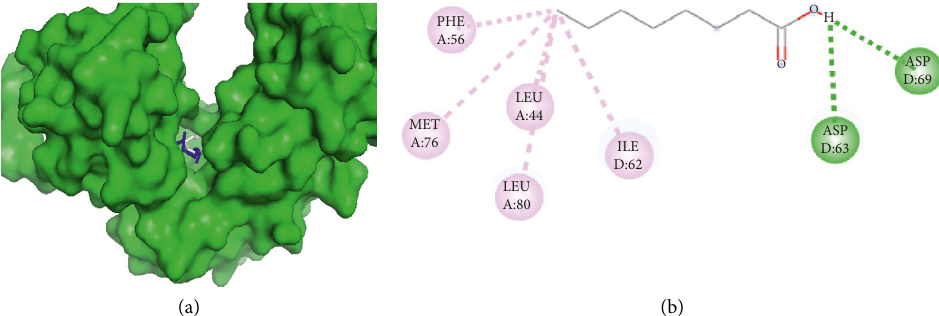
Figure 2: Interaction of caprylic and palmitic acids with filaggrin. (a) 3D visualization: caprylic acid (blue) and palmitic acid (grey). (b) 2D visualization: amino acid residues in caprylic acid and palmitic acid.